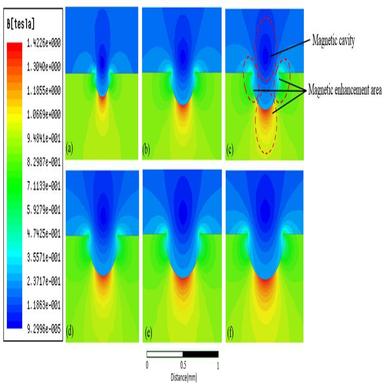
Simulation results of different arc-shaped defect radiuses for HMM; (a) Arc-shaped defect radius of 0.05 mm; (b) Arc-shaped defect radius of 0.1 mm; (c) Arc-shaped defect radius of 0.15 mm; (d) Arc-shaped defect radius of 0.2 mm; (e) Arc-shaped defect radius of 0.25 mm; (f) Arc-shaped defect radius of 0.3 mm.